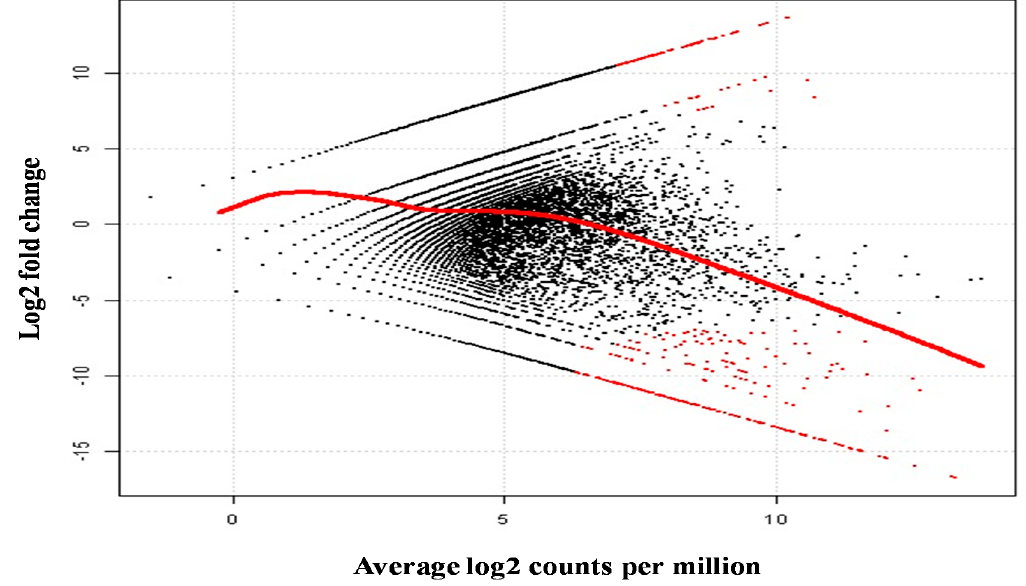
Figure 3. Differential gene expression analysis comparing ovary and testis tissues from M . rosenbergii . Red dots indicate significantly differentially expressed genes (transcripts or contigs) and the red curved line is average expression strength in the plot.